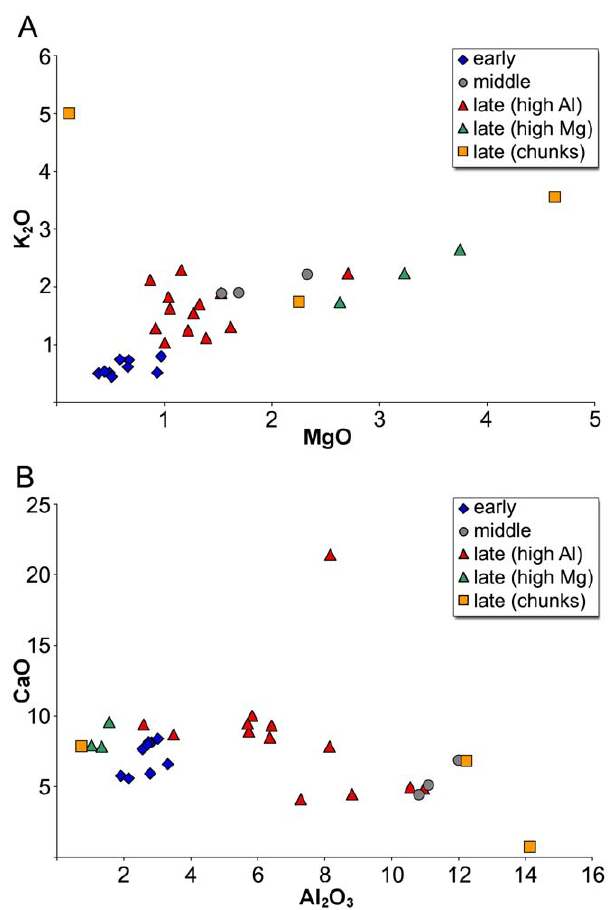
Figure 1. Major element compositions of 31 analysed glass fragments from Pergamon. (A) The comparison of potassium and magnesium oxide concentrations highlight the use of different sources of alkali for the production of different glass groups. The early samples from Pergamon (4 th –7 th c., blue diamonds) show low levels of magnesia and potash ( # 1%), indicating the use of mineral soda. Three late Byzantine samples (12 th –14 th c., green triangles) have high and positively correlated potassium and magnesium oxide concentrations, implying the use of plant ash. Most of the middle (8 th /9 th c., grey circles) and late samples (12 th –14 th c., red triangles), however, have interme- diate potash and magnesia levels (1–2%). Data from analysed glass chunks are shown as yellow squares. (B) Calcium and aluminium oxide contents confirm the division of the Pergamon assemblage into sub- groups. The early Byzantine glasses (blue diamonds) define a relatively narrow cluster, the late plant ash glasses (green triangles) are characterised by very low alumina concentrations, while the majority of the middle (grey circles) and late (red triangles) fragments have significantly increased alumina